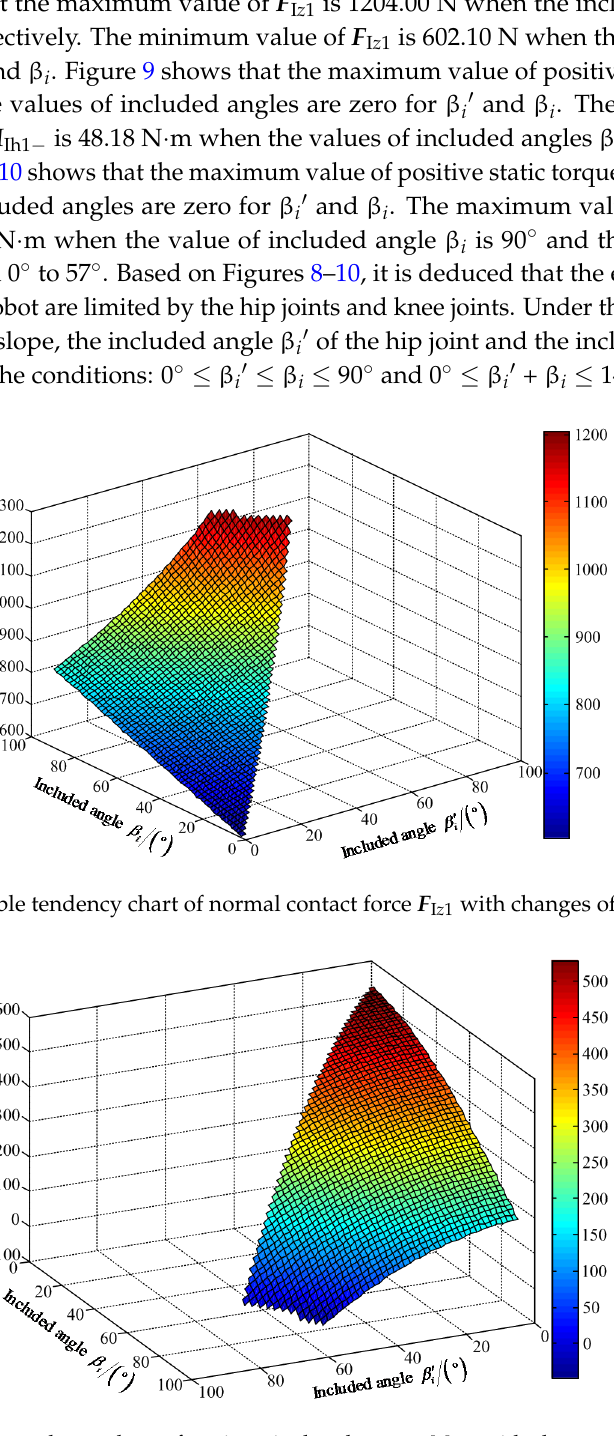
Figure 9. Variable tendency chart of static articulated torque M Ih1 with changes of β i ′ and β i .